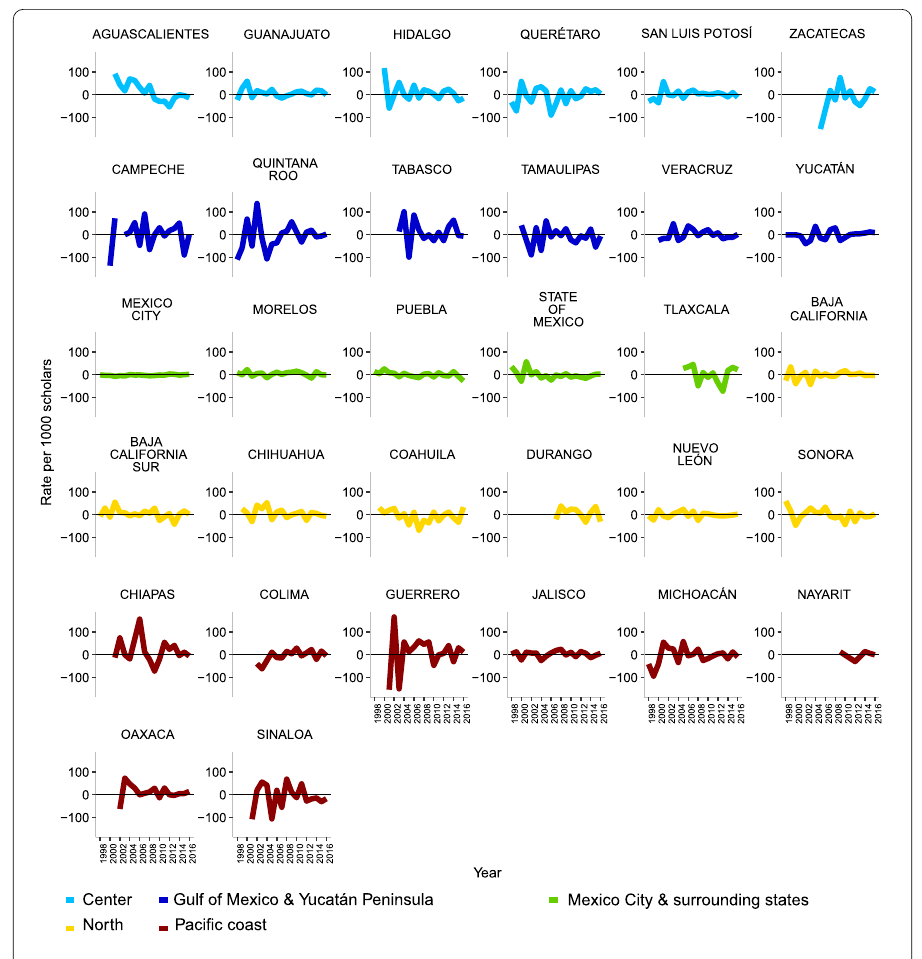
Figure 6 Net migration rates for scholars by